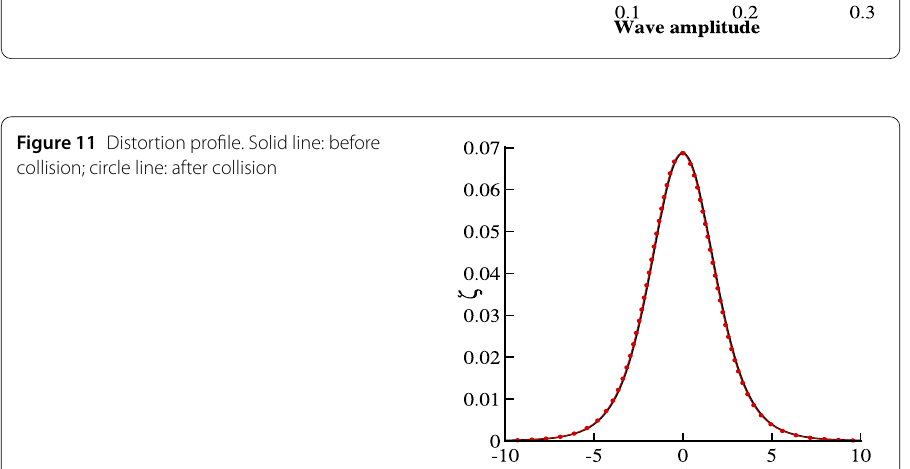
Figure 11 Distortion profile. Solid line: before collision; circle line: after